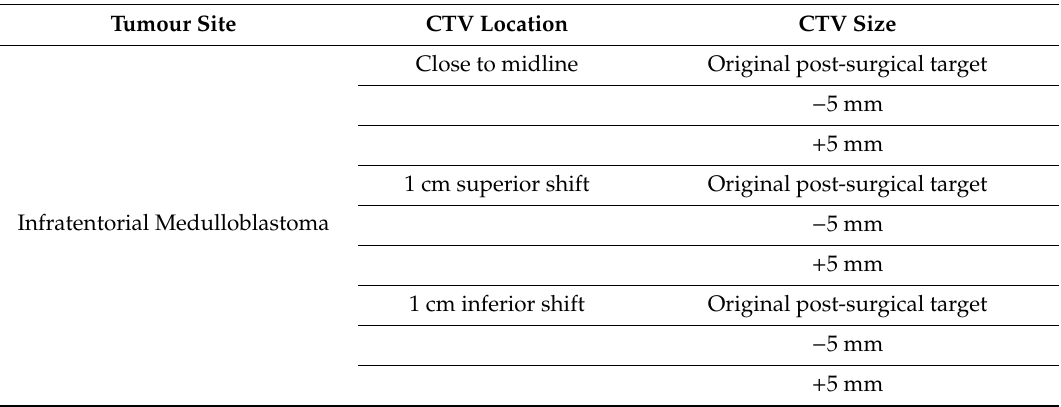
Figure 1. 13-year-old male ( a ) Supratentorial ependymoma (STEP) expansions in clinical target volumes in axial, sagittal, and coronal views (from left to right). ( b ) STEP variations in clinical target volume (CTV) location in axial view (green is the original). ( c ) Medulloblastoma (MB) expansions in clinical target volumes in axial, sagittal, and coronal views (from left to right). ( d ) MB variations in CTV location in sagittal view (green is the original). Table 1. Variations in clinical target volume location and size for each tumour diagnosis.